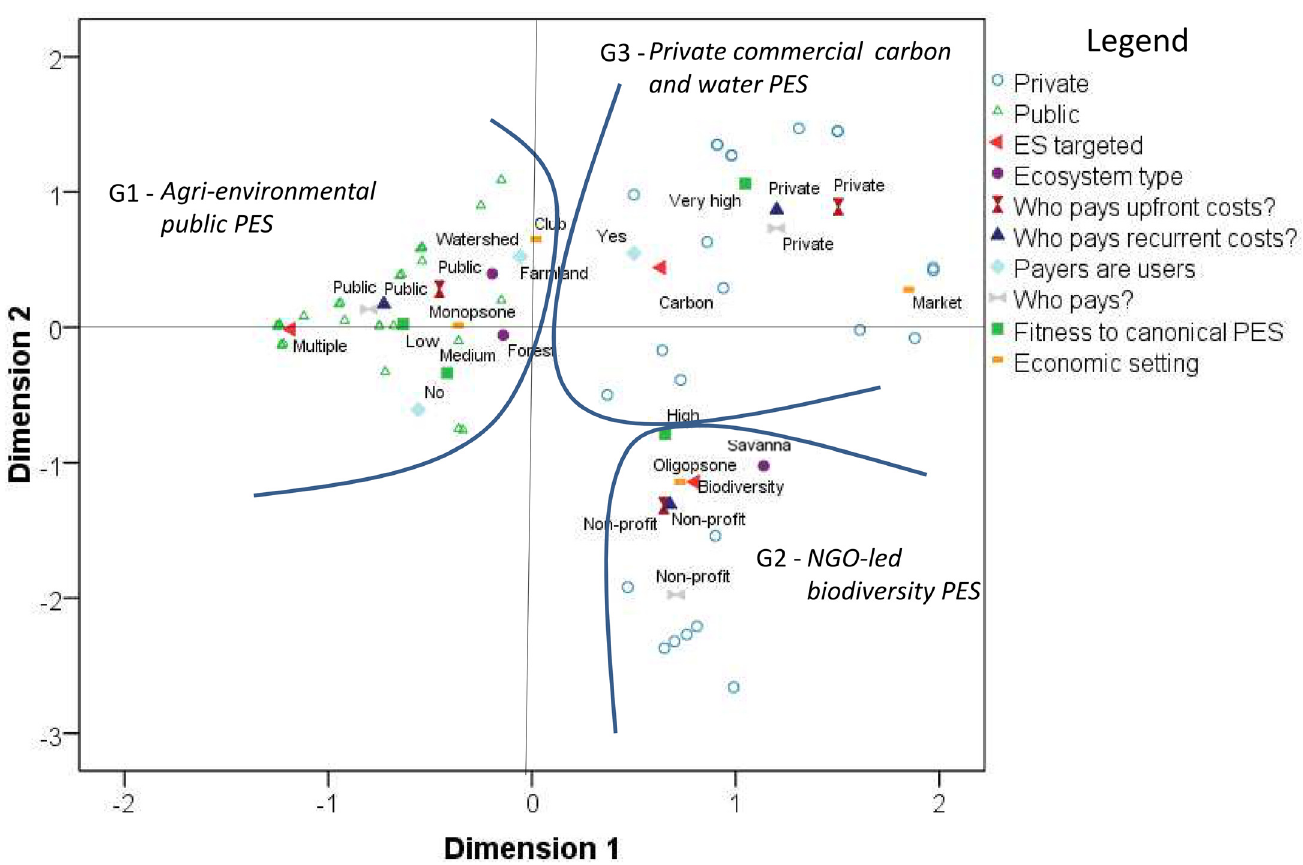
Fig 4. Categorical principal component analysis of main PES design types (see also S2 Table). Triangles refer to public PES, circles to private. G1, G2, G3 refer to PES schemes belonging to cluster groupings 1, 2, and 3, respectively.